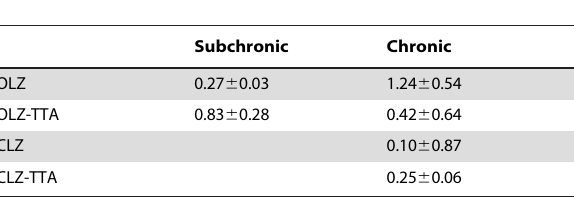
Table 1. Serum levels of antipsychotic